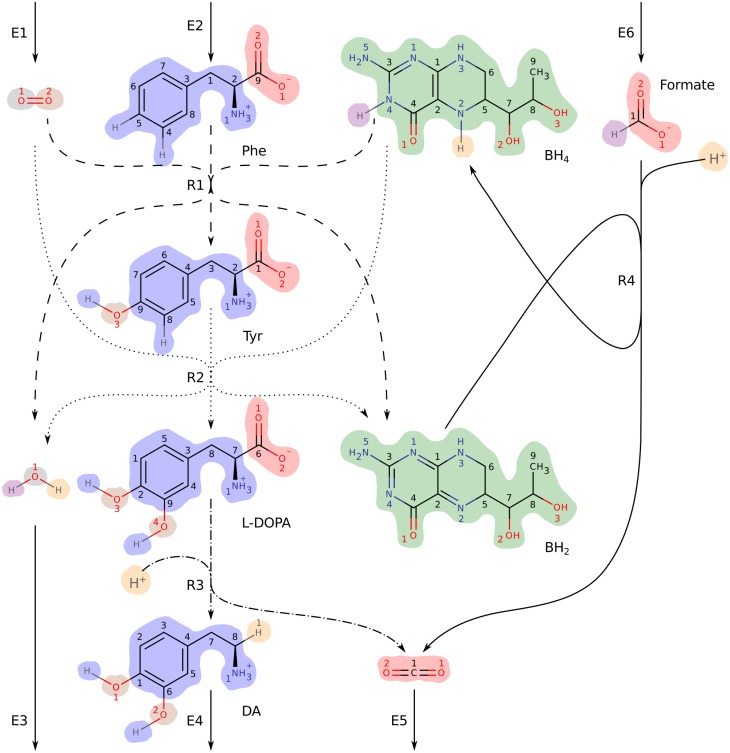
DAS: a small metabolic network consisting of reactions in the human dopamine synthesis pathway.Metabolite abbreviations are, Phe: L-phenylalanine (VMH [23] ID: phe_L), Tyr: L-tyrosine (VMH ID: tyr_L), L-DOPA: levodopa (VMH ID: 34dhphe), DA: dopamine (VMH ID: dopa), BH4: tetrahydrobiopterin (VMH ID: thbpt), BH2: dihydrobiopterin (VMH ID: dhbpt). Internal reactions are labelled R1–R4. R1 (dashed lines) is the phenylalanine hydroxylase reaction (VMH ID: r0399). R2 (dotted lines) is the tyrosine hydroxylase reaction (VMH ID: TYR3MO2 and THBPT4ACAMDASE). R3 (dash-dotted lines) is the DOPA decarboxylase reaction (VMH ID: 3HLYTCL). R4 (solid line) is a composite of the formate dehydrogenase reaction (VMH ID: FDH) and the dihydropteridine reductase reaction (VMH ID: DHPR). Exchange reactions are labelled E1–E6. The hydrogen ion (H+) exchange reaction E7 was omitted to simplify the figure. Atoms are numbered according to their order in each metabolite’s molfile. Atoms of different elements are numbered separately, in colours matching their elemental symbol. Atoms belonging to the same conserved moiety have identically coloured backgrounds.